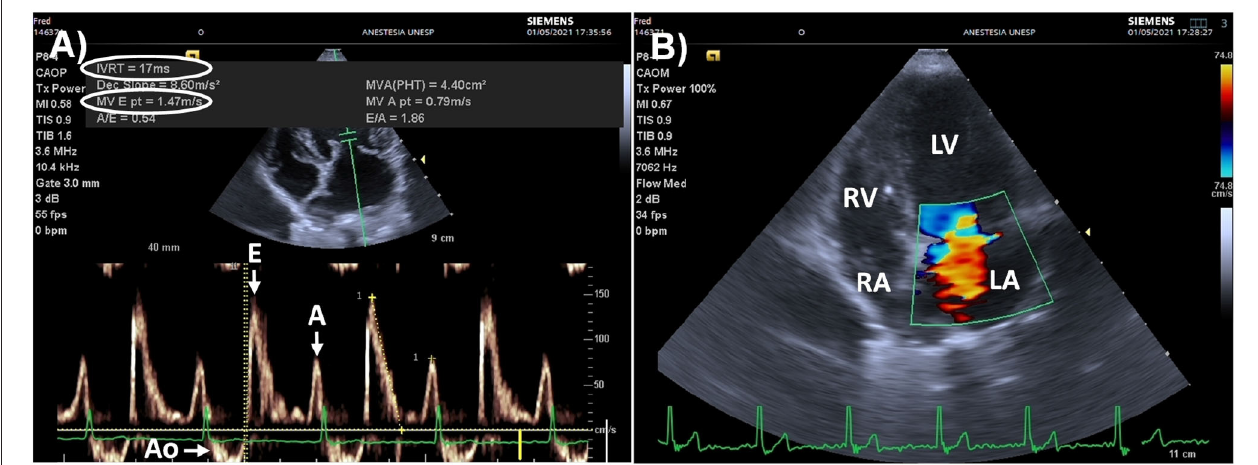
FIGURE 7 | Point of care echocardiography in an 8kg Schnauzer dog presented for surgery due to a bleeding mass located in the upper lip that presented elevated left ventricular filling pressures (LVFP), secondary to myxomatous mitral valve disease. (A) Pulsed wave Doppler of mitral inflow (left apical, four/five-chamber view) showing marked acceleration of the early passive diastolic filling wave (E wave = 147 cm/s, normal range: 53–108 cm/s). The isovolumic relaxation time (IVRT) was low (17ms, normal range: 43–63ms), and the E/IVRT ratio was markedly increased (8.64, upper reference value: 2.5), indicating high LVFP due to congestive heart failure. (B) Color Doppler (left apical, four-chamber view) showing mitral regurgitation during mid systole. This animal was anesthetized as an emergency procedure with the recommendation for a restrictive fluid therapy strategy. Inotropes/vasopressors instead of fluid boluses were recommended to manage intraoperative hypotension. The congestive heart failure was later managed by a cardiologist. Ao, aorta; E, early passive diastolic filling wave, A, late diastolic filling wave induced by atrial contraction; RV, right ventricle; RA, right atrium; LV, left ventricle; LA, left